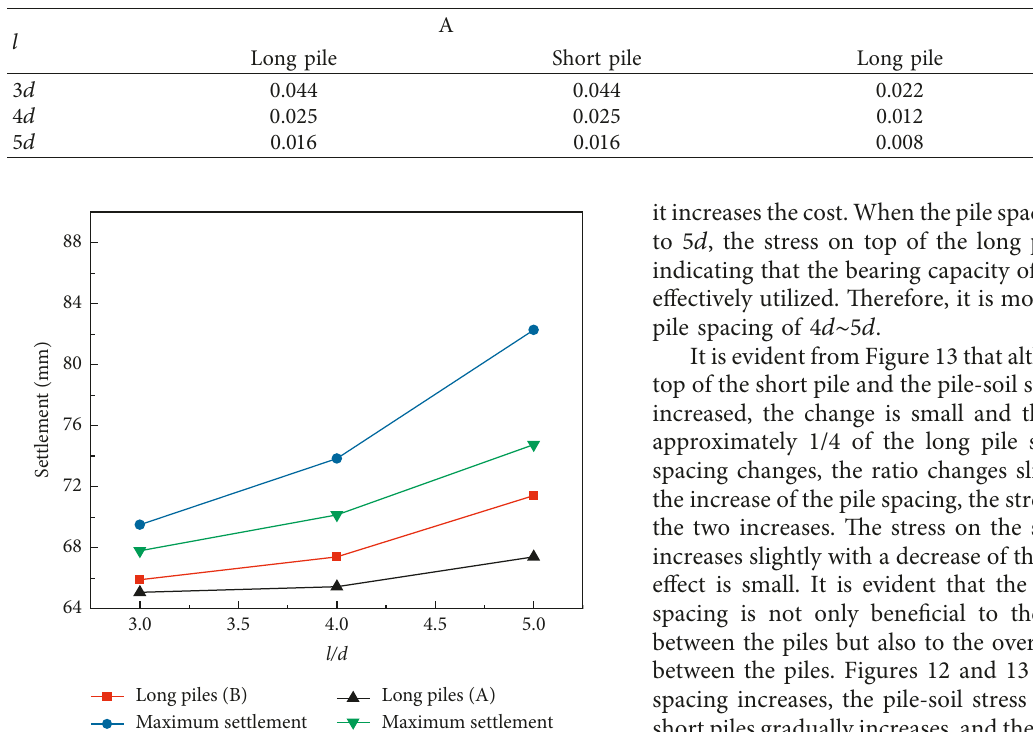
Figure 11: Long and short pile arrangement. (a) A. (b) B. Table 6: Replacement ratios corresponding to different arrangements.